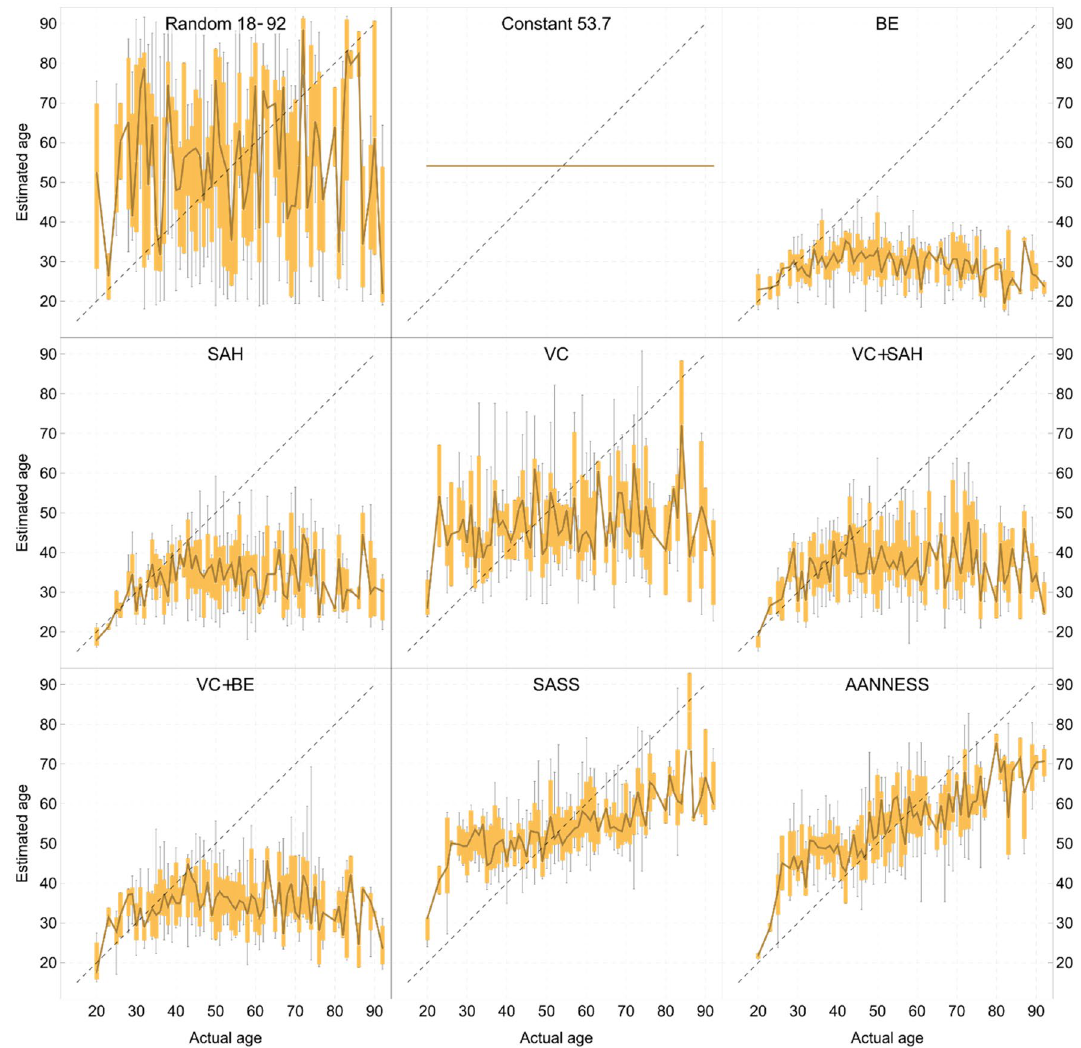
Figure 8. Visual comparison of all evaluated models from Table 4. Each image shows a variation of age estimations for a particular age for a given model. More specifically, for a certain age, the conventional box plot is used, i.e. it shows the minimum, maximum, q1, q2 (median) and q3 quartiles. The dark brown central line connects the median values. The black dashed line represents an ideal estimation, i.e. the closer to this line the model is, the